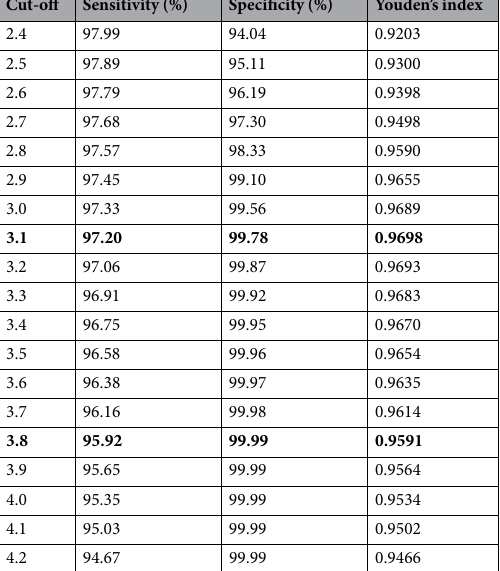
Cut-off Sensitivity (%)